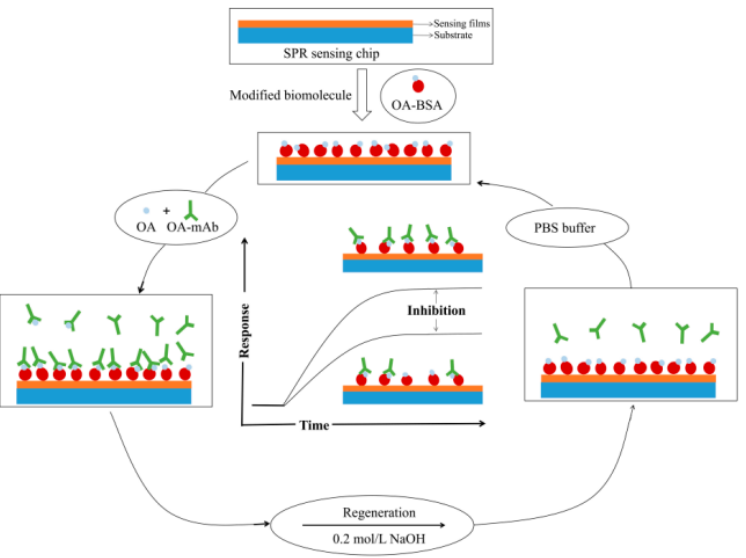
Figure 10. The flowchart for the method of detecting okadaic acid (OA). Reproduced from [103] (CC